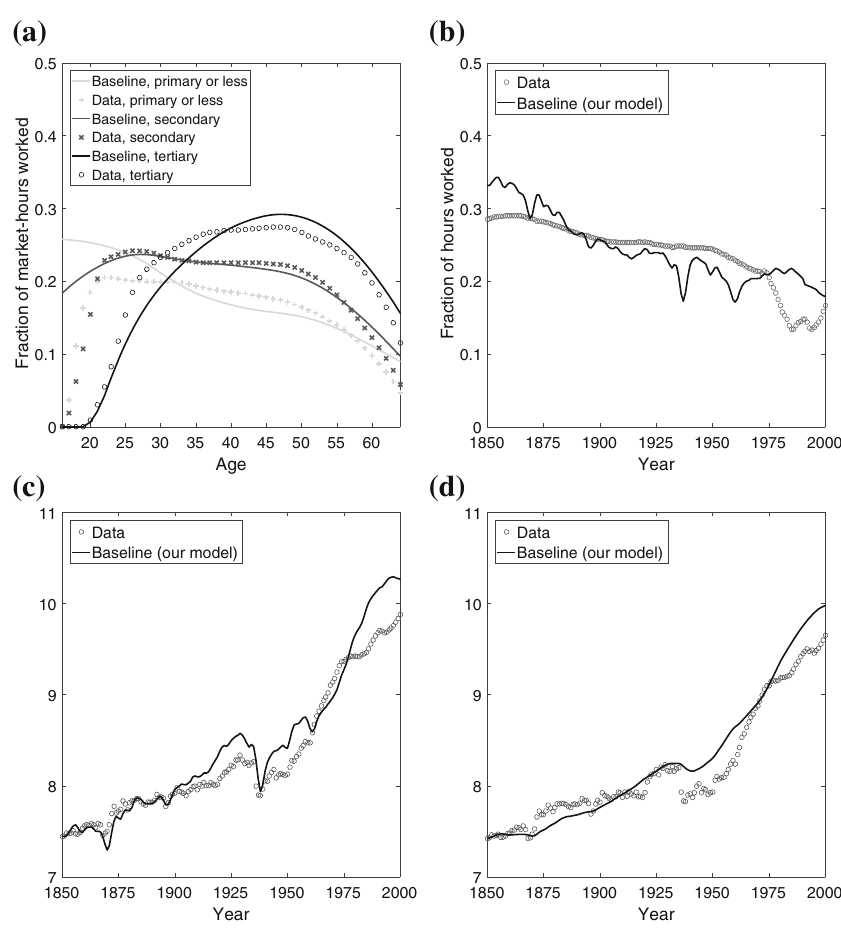
Fig. 7 In-sample performance of the model, Spain 1850–2000. a Fraction of per-capita hours worked by educational attainment, average of the 1987–2013 period, b average hours worked by working-age population, c income per capita (in logs) and d consumption per capita (in logs). Source See text on Fig. 4 for panels 7a, b. National accounts data are taken from OECD (2015c) and Prados de la Escosura and Rosés